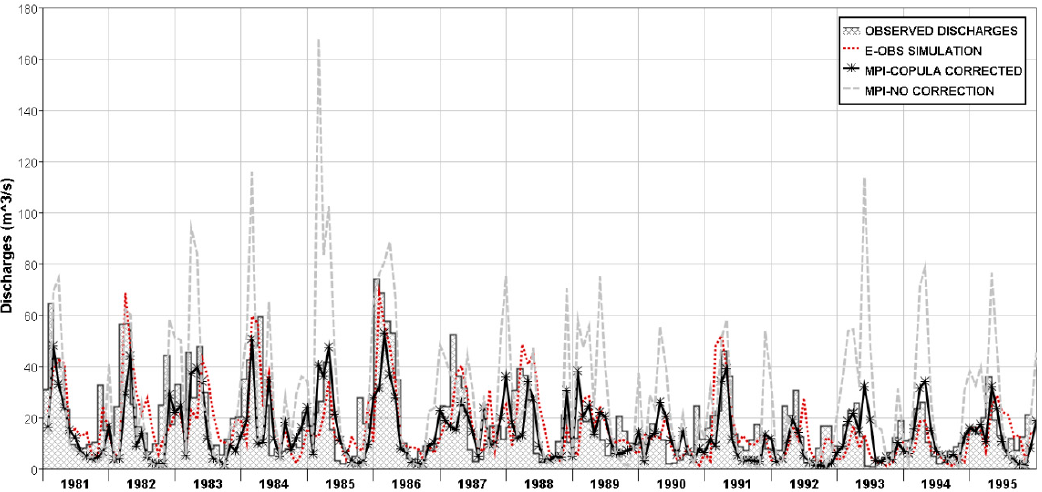
Figure 10. Hydrological model simulated discharges at the borders of the two countries that share the basin. Observations (hashed area) and E-OBS simulation results (red dotted curve) versus MPI-copula corrected discharges (black curve) and MPI-no corrected discharges (grey dashed curve).